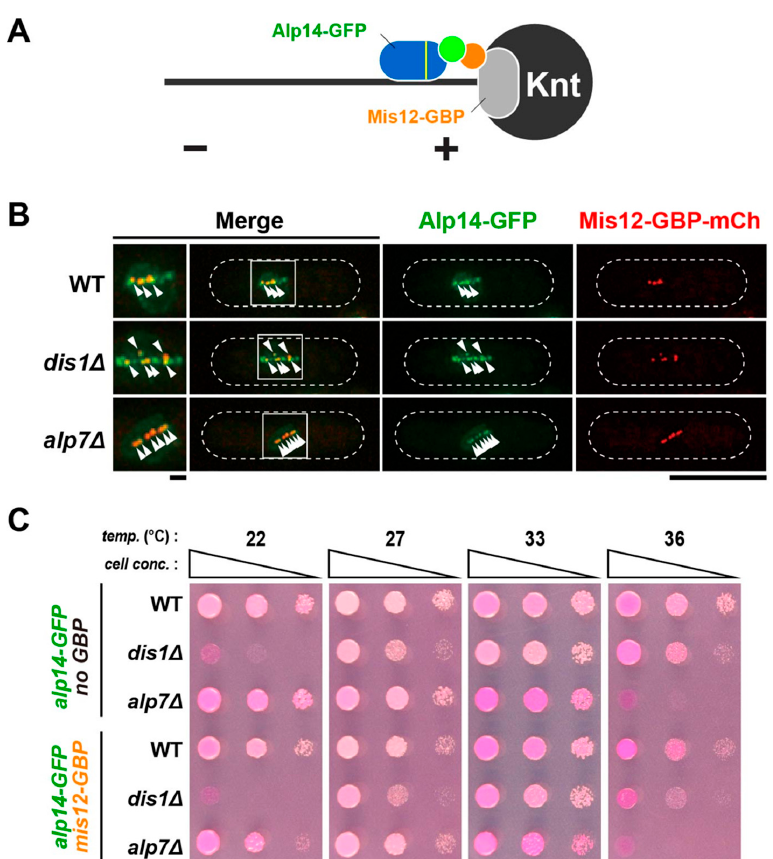
Figure 6. Kinetochore-tethered Alp14 is incapable of rescuing dis1 ∆ . ( A ) A schematic illustration of a strategy for tethering Alp14 to the kinetochore (Knt). To ensure nuclear entry of Alp14, a canonical nuclear localisation signal (NLS) sequence [41] was added together with GFP to the C terminus of Alp14 (Alp14 NLS -GFP) [42]. ( B ) Visualisation of Alp14 NLS -GFP localisation in strains containing Mis12-GBP-mCherry. Cell peripheries are indicated with dotted lines and areas containing spindle MTs (squares) are enlarged in the left-hand side panels. Kinetochores are marked with arrowheads. Note that Alp14 NLS -GFP and Mis12-GBP-mCherry do not completely colocalise; additional Alp14 NLS -GFP dots are observed in a dis1 ∆ cell. This could represent the SPBs, to which Alp14 is normally localised [15,43]. Scale bars, 1 µm (left) and 10 µm (right). ( C ) Spot test. Indicated strains were serially (10-fold) diluted, spotted onto rich YE5S plates containing Phloxine B and incubated at the indicated temperatures for 2–3 d.